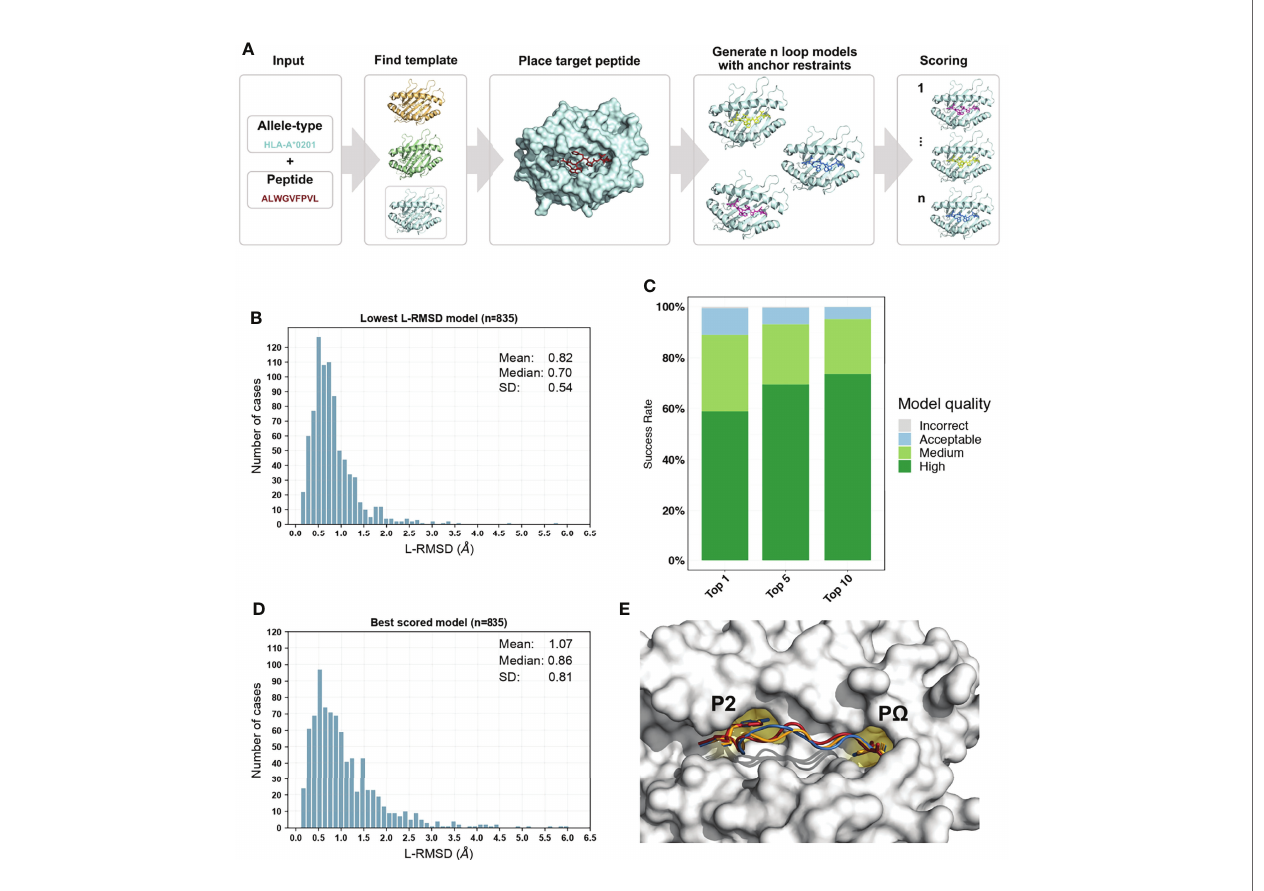
FIGURE 2 | Overview of PANDORA pMHC-I protocol and its performance on 835 pMHC-I complexes with X-ray structures. (A) PANDORA schematic fl owchart. An allele type and peptide sequence of a target pMHC-I case are given as input. This information is used to identify the best matching template structure from a local database of pMHC-I structures. The target MHC is then modelled on top of the template and its peptide (red) is superposed on the template peptide. The anchor positions (speci fi ed by the user or by other tools, see section 2.4) are then speci fi ed as fi xed. MODELLER then generates 20 loop models maintaining the anchor restrained. Finally, all models are scored with MODELLER internal molpdf scoring function. (B) Sampling performance of PANDORA in our cross-docking benchmark experiment. Histogram of the lowest backbone L-RMSD models is shown. (C) Success rate of Backbone L-RMSD at different thresholds according to CAPRI criteria: High-quality (L-RMSD <1 Å), Medium, (<2 Å), Acceptable (<5 Å), and Incorrect (<10 Å) (Lensink et al., 2020). (D) Complete performance of PANDORA (modelling + scoring). Histogram of the backbone L-RMSD of the best molpdf models is shown. (E) Example of an average-quality 3D model generated with PANDORA. The target peptide (PDB ID: 3I6L) is marked in red; the template structure (PDB ID: 3WL9) is marked in blue; the model structure is marked in